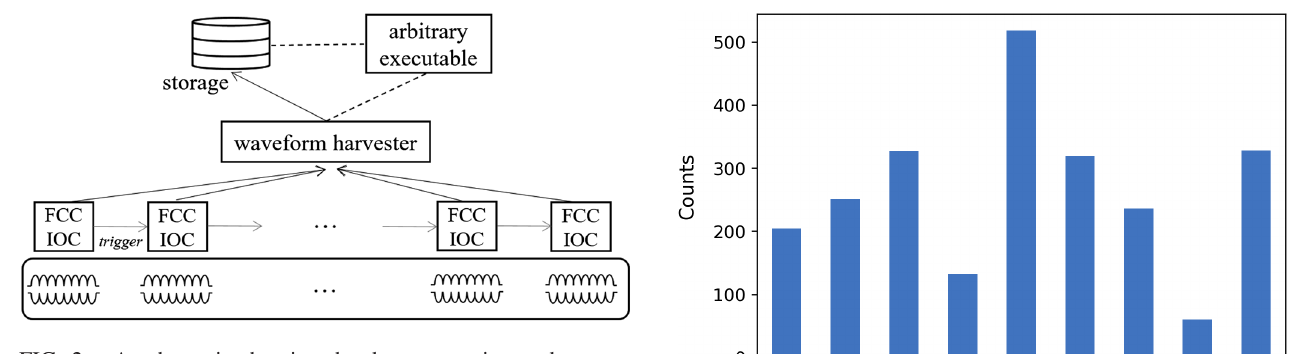
FIG. 2. A schematic showing the data generation and storage systems. A fault at a cavity triggers data collection at that cavity ’ s FCC input or output controller (IOC), and the fault trigger is propagated to neighboring FCC IOCs associated with the cryomodule.